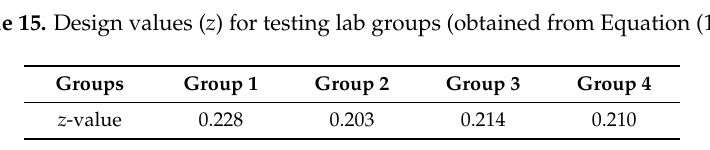
Table 15. Design values ( z ) for testing lab groups (obtained from Equation (17)). Table 16. Design values ( z ) for cutting facilities groups (obtained from Equation